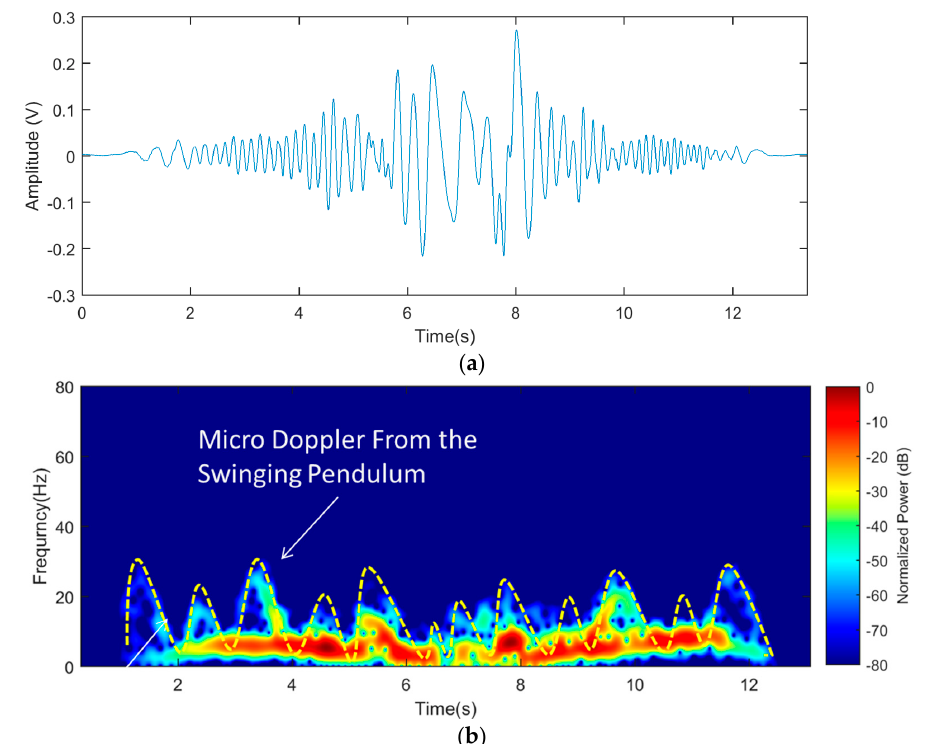
Figure 16. Pendulum swinging on the trolley in forward motion with a release angle, θ 0 = 20 ◦ : ( a ) time domain for Doppler signature; and ( b ) its spectrogram.